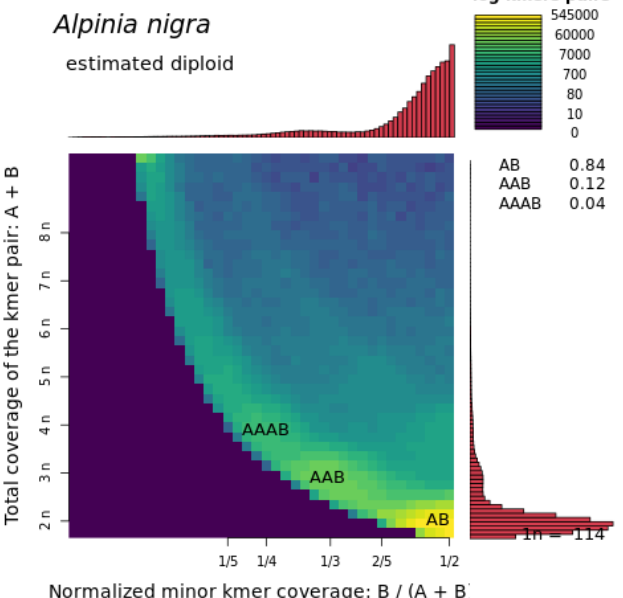
Figure 5. Smudgeplot for Alpinia nigra for k = 21. The colour intensity of the smudge indicates how frequently the haplotype structure is represented in the genome. The bar plots represent the sequencing coverage.